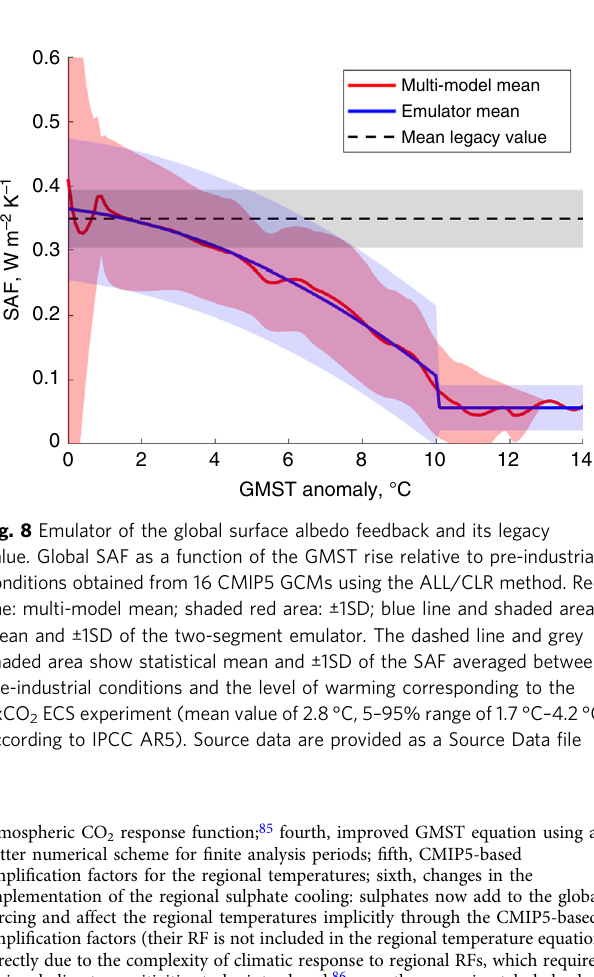
ampli fi cation factors for the regional temperatures; sixth, changes in the implementation of the regional sulphate cooling: sulphates now add to the global forcing and affect the regional temperatures implicitly through the CMIP5-based ampli fi cation factors (their RF is not included in the regional temperature equation directly due to the complexity of climatic response to regional RFs, which requires regional climate sensitivities to be introduced; 86 seventh, approximately halved indirect sulphate cooling effect; eighth, fat-tailed distribution for the sea level rise (SLR) time lag (at the lower values end) to account for the possible acceleration in the discharge from the West Antarctica and Greenland ice sheets 87 – 90 . Economics updates in PAGE-ICE: fi rst, new economic impact function based